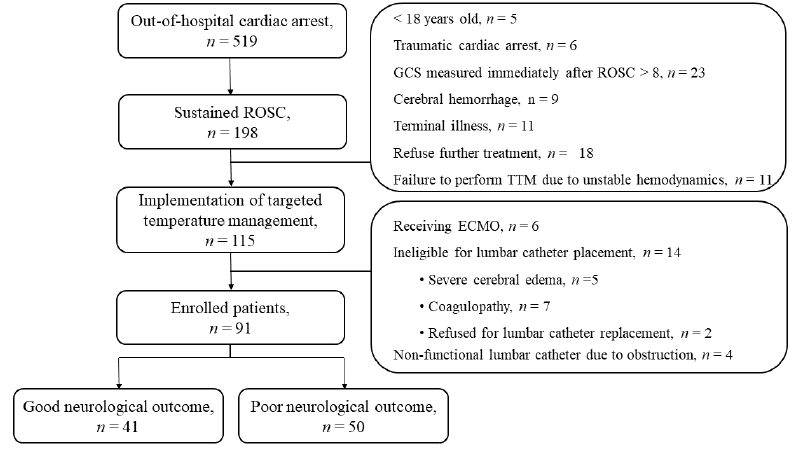
Figure 2. Flow diagram of patient inclusion. ECMO: extracorporeal membrane oxygenation; GCS: Glasgow coma scale; ROSC: return of spontaneous circulation; TTM: targeted temperature management.